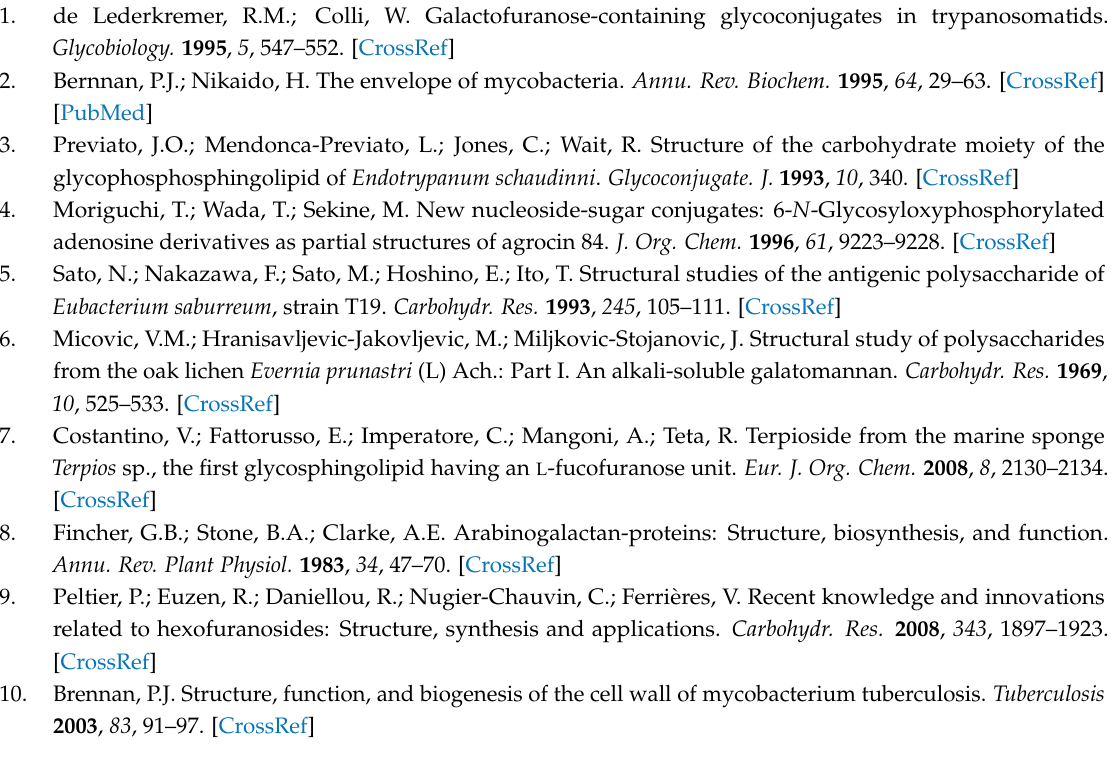
Supplementary Materials: The following are available online. Figure S1–S42: The NMR spectra of compounds 5 – 13 and 15 – 19 ; Figure S43–S46: The HPLC traces of 16 – 19